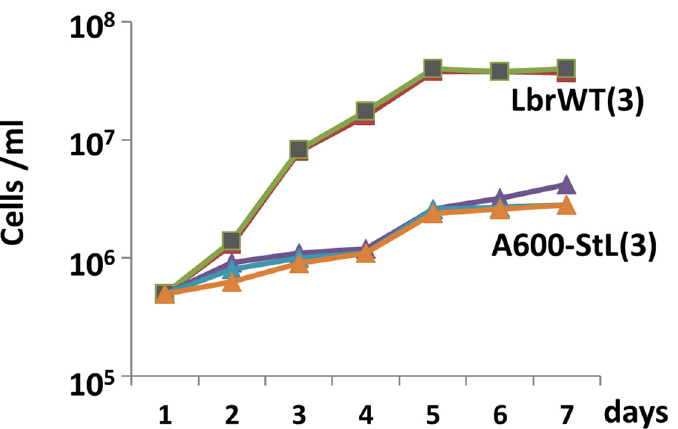
Figure 4. Impact of LbrA600 -StL amastigote growth in L. braziliensis . WT or A600- StL transfectants grew normally as promastigotes; the figure shows parasites inoculated at a density of 5 × 10 5 /mL and the cell numbers determined daily for 1 week. WT ( ■ ) was repeated three times along with 3 different A600 -StL knockdown clonal lines (#1–3; triangles). Across 2 experiments with WT (3 replicas each) and 7 different A600 -StL lines the difference was highly significant ( p < 0.0001).